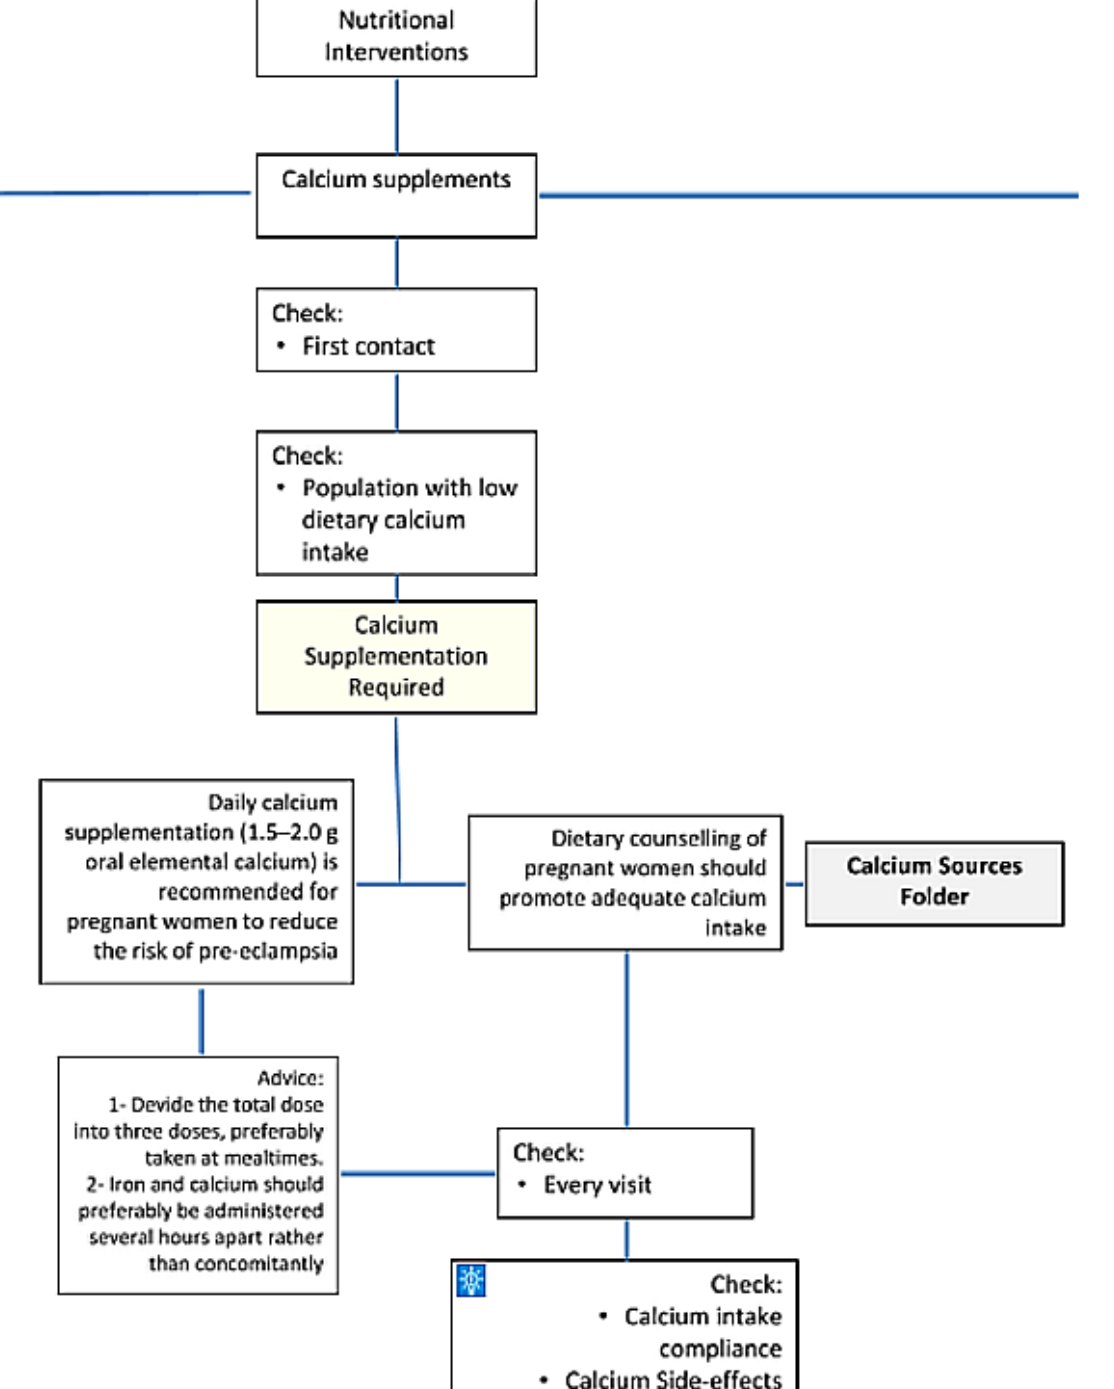
Figure 3. Example of the clinical algorithm: calcium supplementation